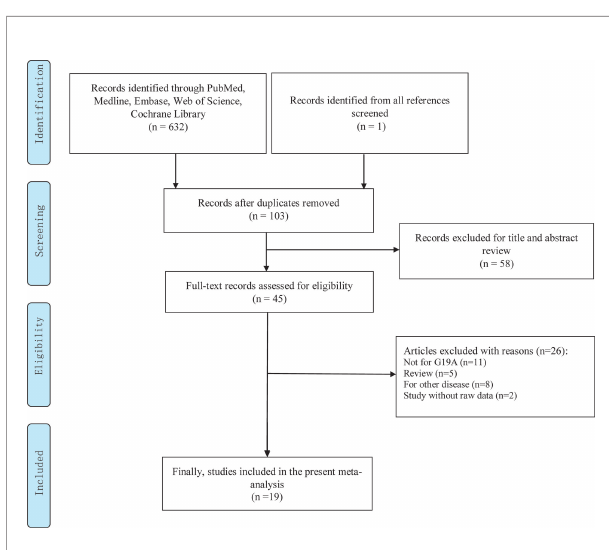
FIGURE 1 | Flowchart of literature